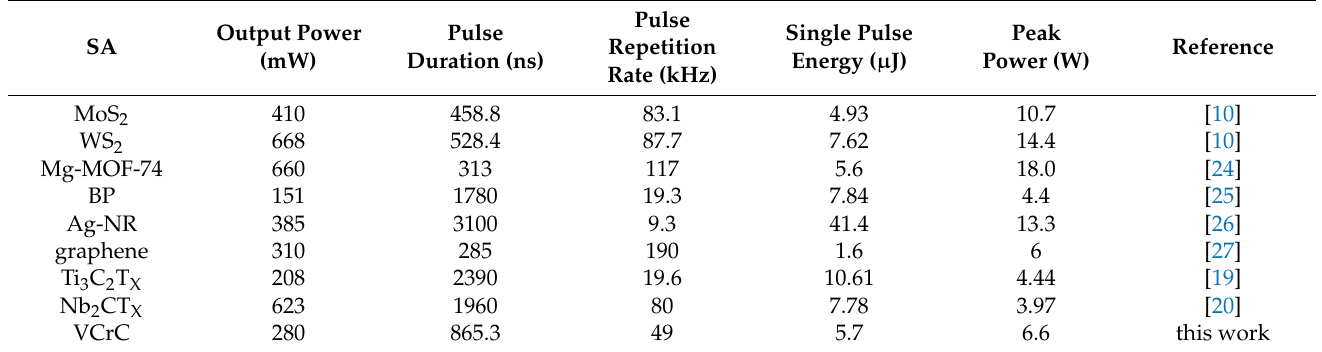
Table 1. Performance comparison of PQS lasers with different SAs at 2 µ m